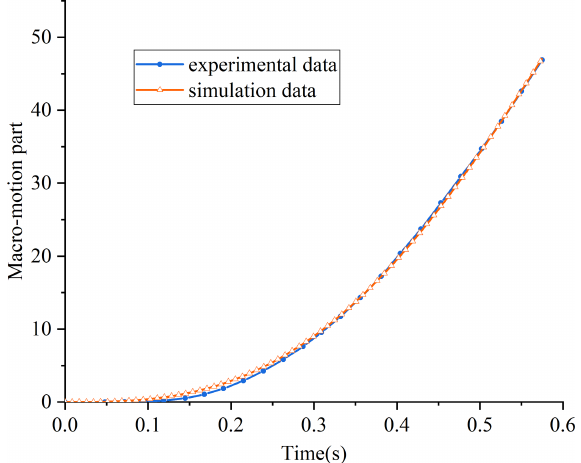
Figure 18. Comparison curve of velocity simulation value and ex- perimental value of the macro–micro composite